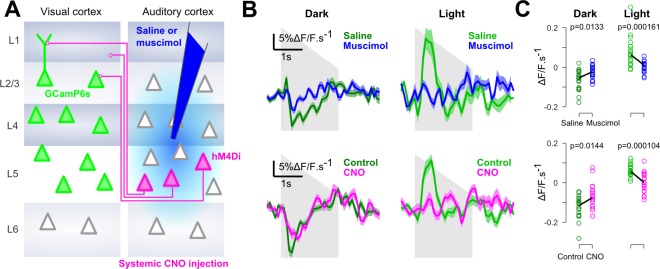
Auditory responses in V1 are caused by direct AC projections.(A) Schematics of the AC inactivation experiment (blue) and of the chemogenetic inactivation experiment in which V1-projecting neurons in AC are specifically silenced (magenta). (B) (top) Mean deconvolved calcium signal of V1 neurons in dark (dark green) or in light (light green) during saline injections (n = 765 neurons in four experiments and three mice) or muscimol inactivation of AC (n = 825 neurons in five experiments, same three mice). (bottom) Same as top graphs but for chemogenetic inactivation of V1-projecting neurons in AC (same n = 743 neurons before and after CNO activation, in three experiments and two mice). Shading indicates SEM. (C) Mean deconvolved calcium signal from the population responses shown in B for the saline (green) versus muscimol (blue) conditions and for Control (green) versus CNO (magenta) conditions (computed from 200 to 500 ms after sound onset for the negative responses in the dark, and from 200 to 1000 ms for the positive response in the light). The p-values are derived from a two-sided Wilcoxon sign test (n = 40 stimulus repetitions).